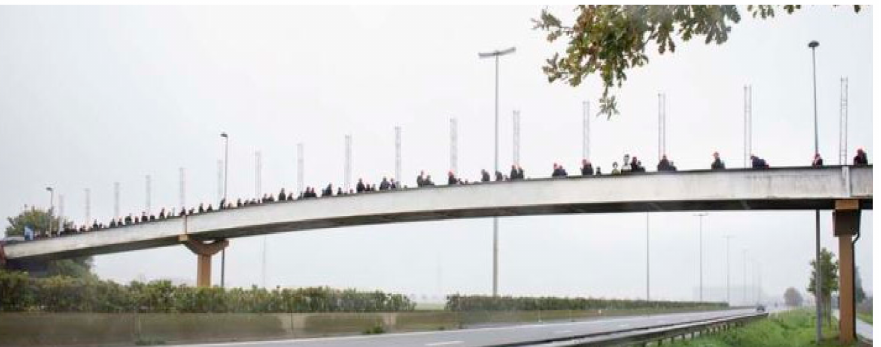
Figure 2. Eeklo Bridge